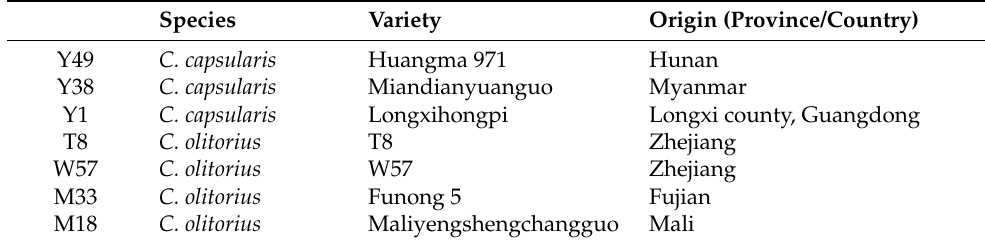
Table 1. Origin of 7 varieties of C. capsularis and C. olitorius . Species Variety Origin (Province/Country) Y49 C.